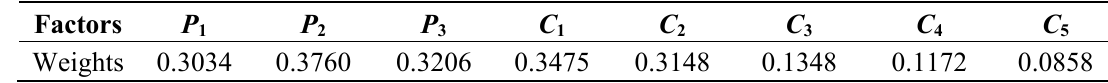
Table 1. The weights of